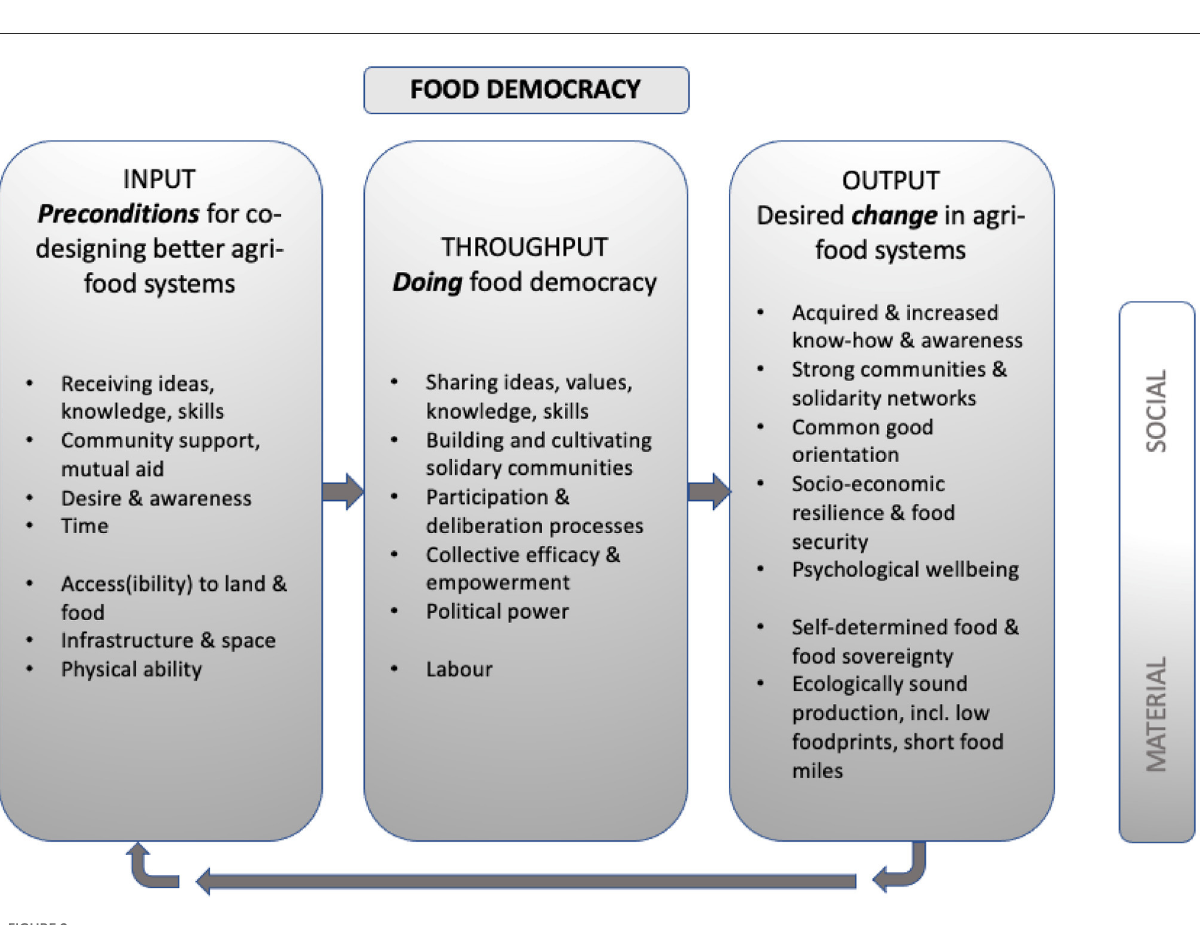
and was guided by the concepts of deep, participatory, and strong democracy (as a constitutive process), as well as the suggested frameworks of Hassanein (2008) and Bornemann (2022). These